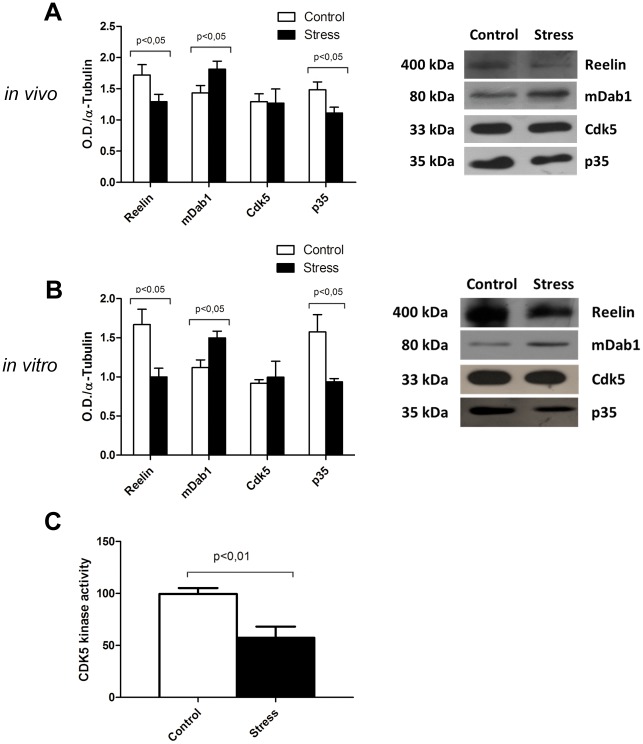

In vivo (A) and in vitro (B) expression of Reelin and downstream elements in control and stress conditions analyzed by Western Blot.The left side of the panel shows the result of density pixel quantification, the right side shows a representative example of each protein expression. Expression levels observed in vivo are maintained after 5 DIV. Values are mean ± SEM. n = 8–12 per group at in vivo experiments, n = 3 per group at in vitro experiment. (c) Cdk5 kinase activity measured from protein extract from brain cortex of control (n = 5) and stressed (n = 4) rats. All data are presented as the mean and SEM. * p < 0.05.